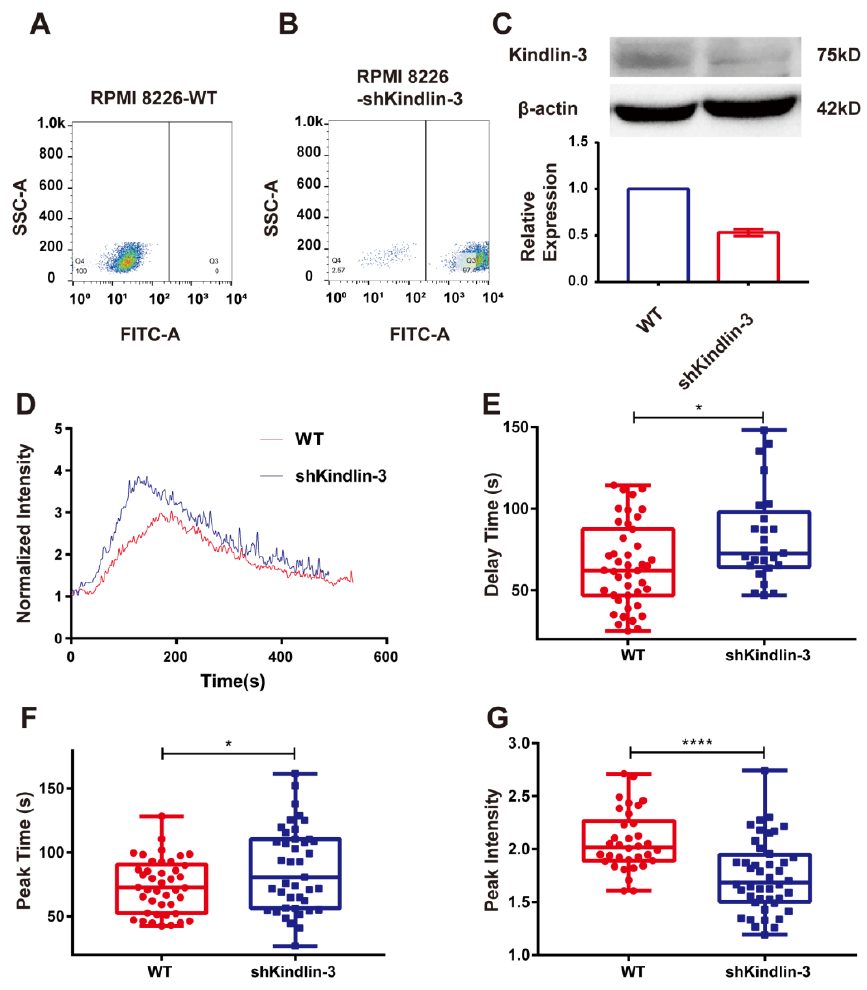
Figure 6. The effects of silencing Kindlin-3 on the calcium signaling of RPMI 8226 cells mediated by integrin α 4 β 7 /MAdCAM-1 complex in flow. ( A , B ) Positive rate of the RPMI 8226 cell line stably transfected by Kindlin-3 short hairpin RNA (shRNA) (RPMI 8226-shKindlin-3) compared to a non-transfected cell line (RPMI 8226-WT) identified by flow cytometry. ( C ) Western blotting verified the relative expression of total protein levels of Kindlin-3 between the RPMI 8226 cell line stably transfected by Kindlin-3 shRNA (shKindlin-3) and non-transfected one (WT). ( D ) Time course, ( E ) delay time, ( F ) peak time, and ( G ) peak intensity of integrin α 4 β 7 /MAdCAM-1 complex-induced calcium signaling of RPMI 8226 cells, with or without the silence of Kindlin-3, at a wall shear stress of 0.3 dyn/cm 2 . Data of each group were shown by boxplot with raw data points, where each horizontal line from top to bottom of a boxplot represents the maximum, upper quartile, median, lower quartile, and minimum for the group, respectively. At least 15 typical calcium signaling events of the firmly adhering cells should be collected among three repeat experiments for each group. Significant differences from the control group (non-treated cells) are shown by p -value, with * for p < 0.05 and **** for p <